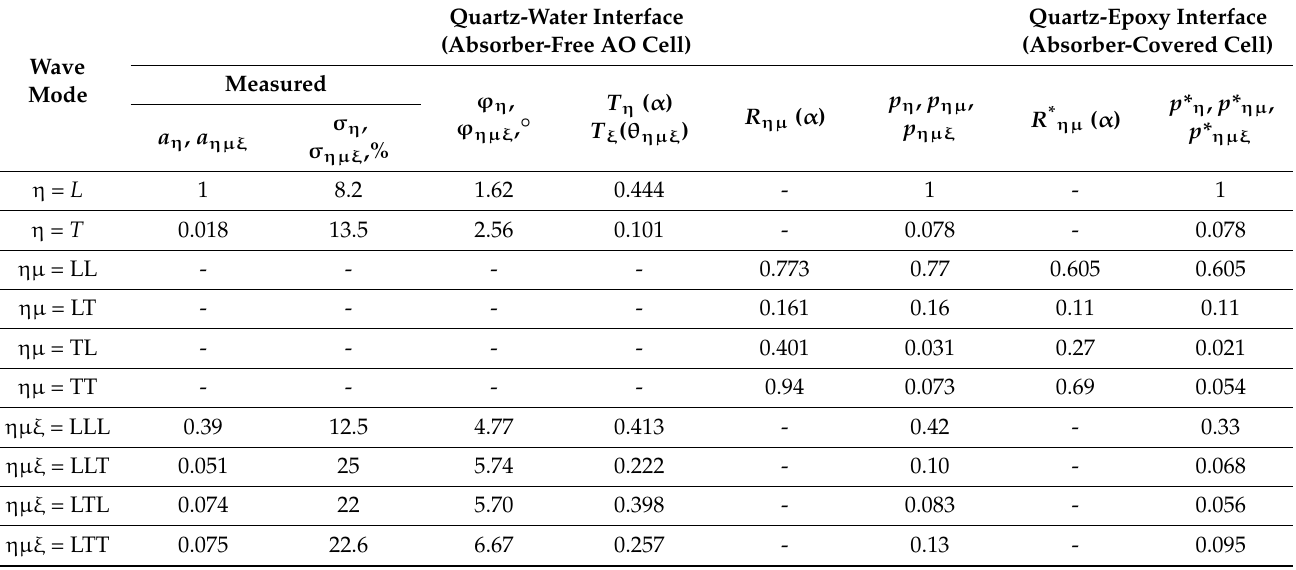
Table 2. Experimental data for absorber-free AO cell and AO cell covered with ultrasound absorber: refracted angles ( φ ), normalized amplitudes ( a , p ), transmission ( T ) and reflection ( R ) coefficients for various modes and given inclination angle ( α = 6.5 ◦ ).